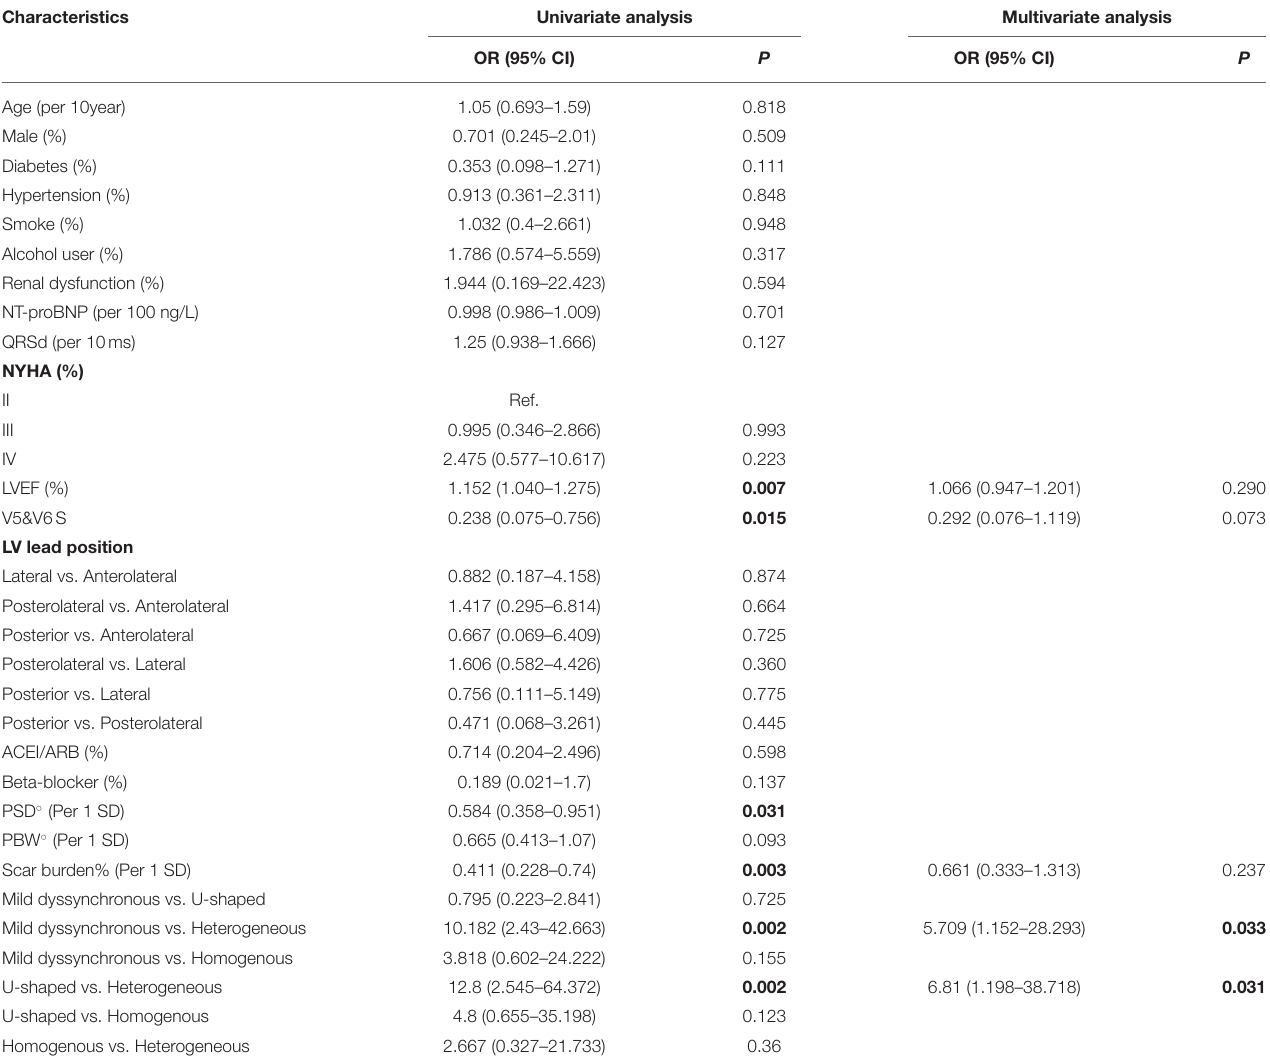
TABLE 2 | Univariate analysis and multivariable models for CRT super-response.